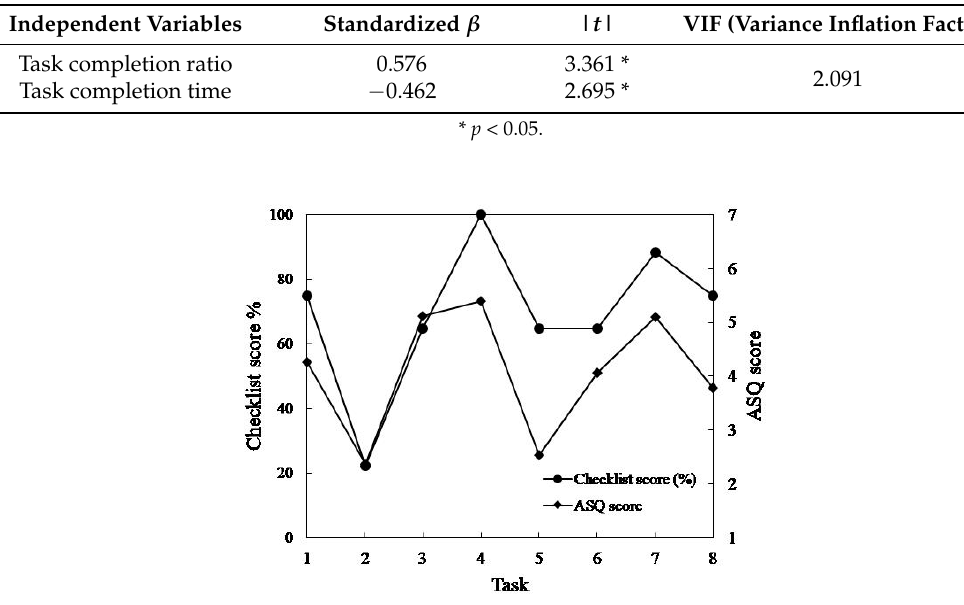
Figure 3. Usability score of each task for the proposed checklist and. ASQ, after-scenario questionnaire.